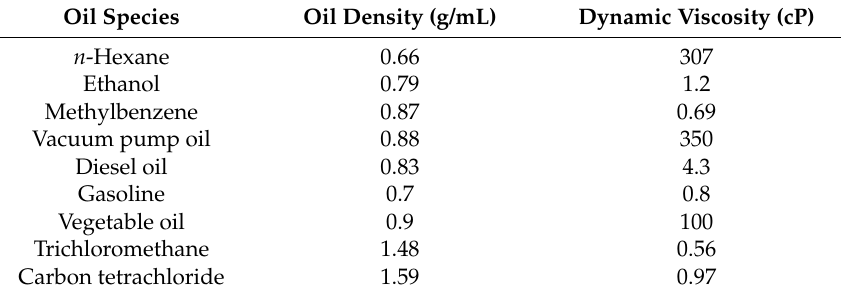
Table 3. Types and properties used in oil sorption testing.